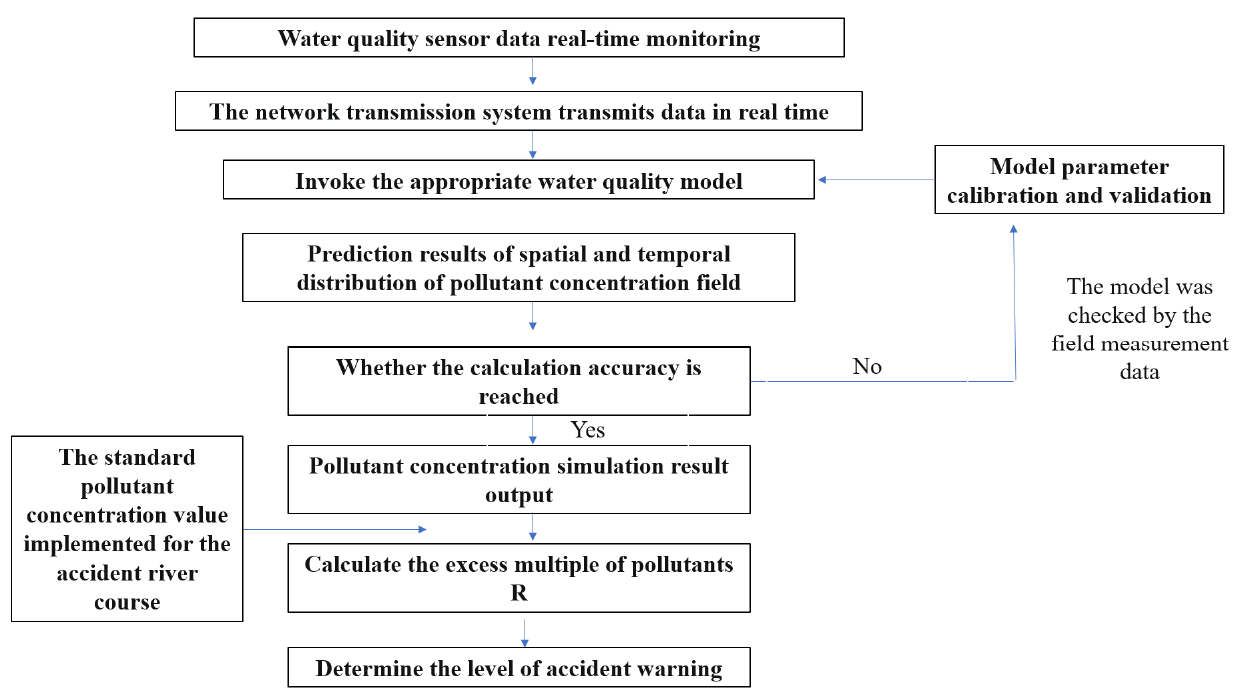
Figure 4. Structure of the accident early warning technology.